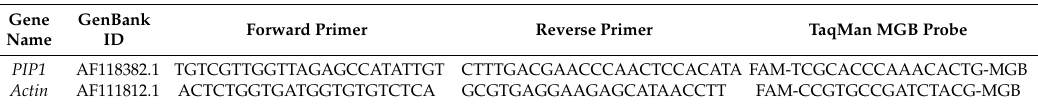
Table 1. Genes, sequence origins, and the primers and probes that were designed and used in the